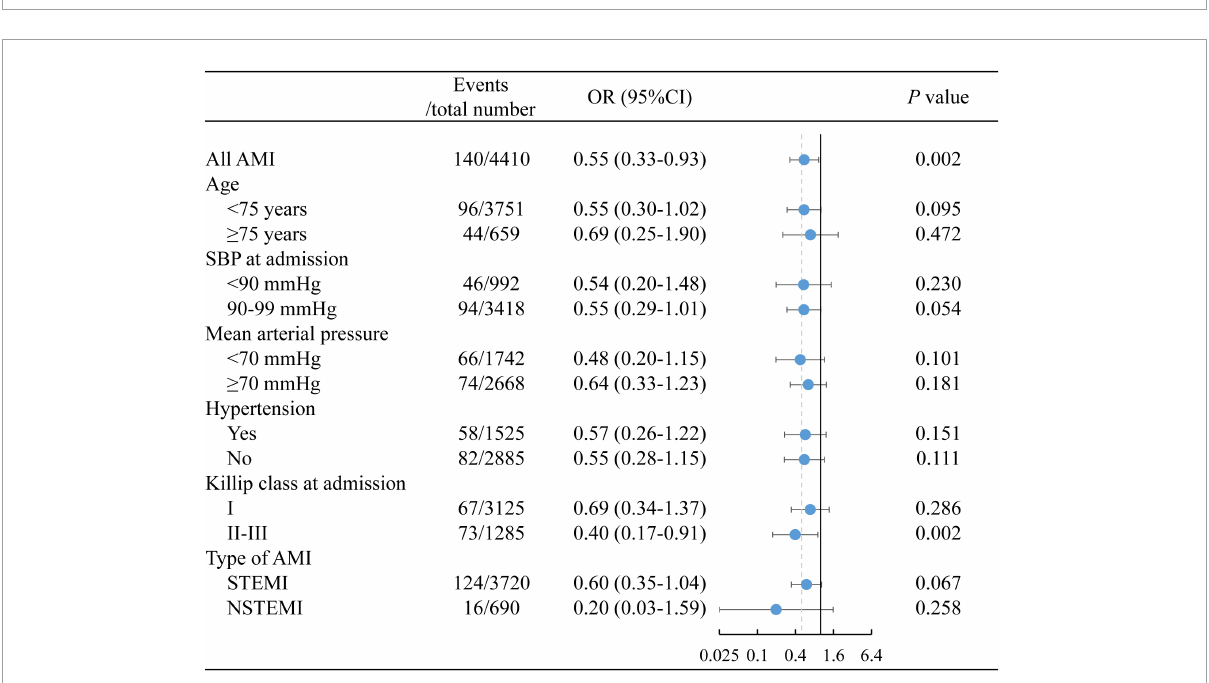
FIGURE2 The association between early ACEI/ARB use and in-hospital MACEs. ACEI, angiotensin-converting enzyme inhibitor; ARB, angiotensin receptor blocker; MACEs, major adverse cardiac events.